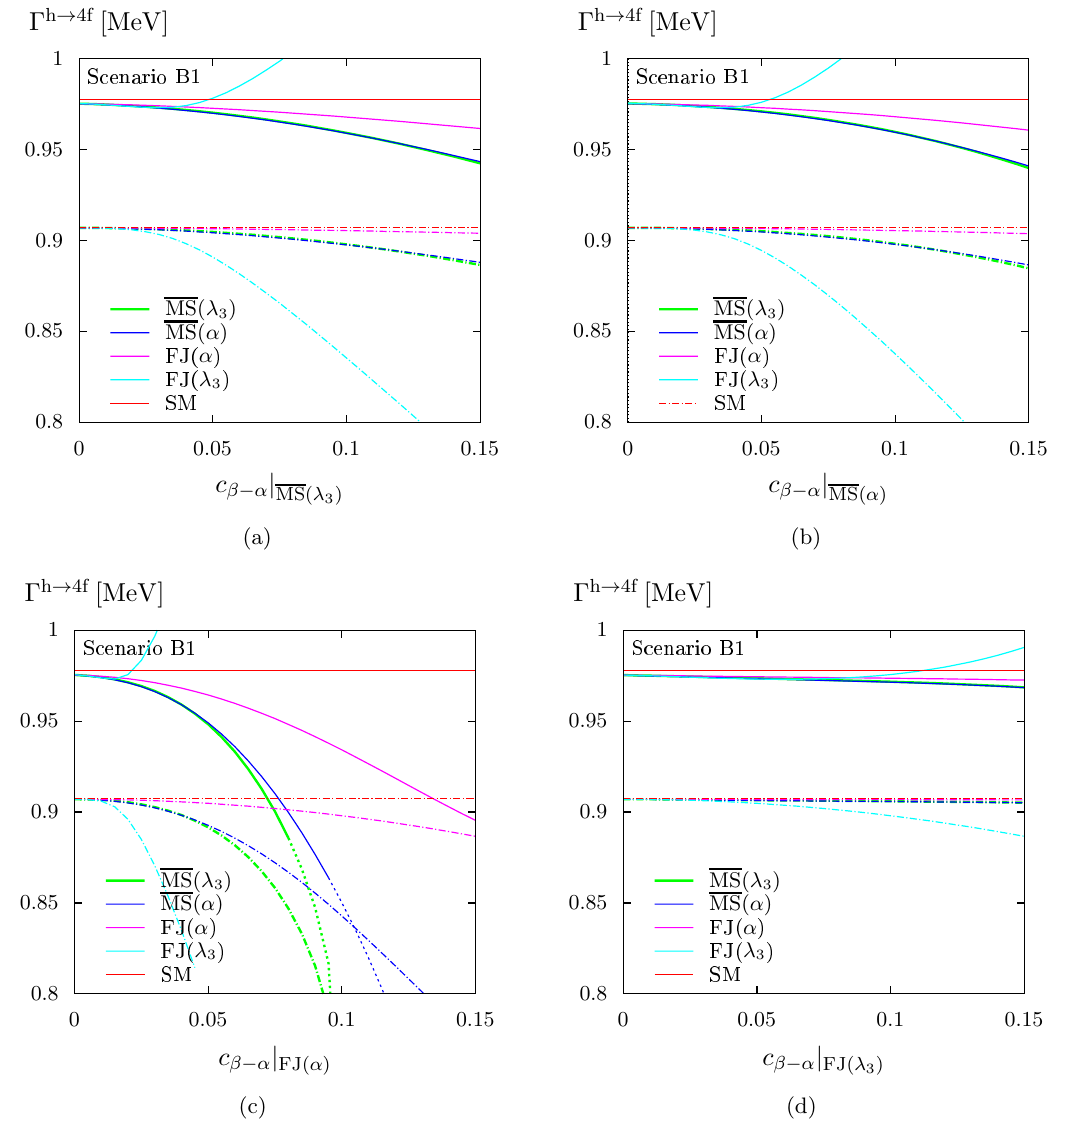
Figure 24 . The h 4 f width at LO (dashed) and NLO EW+QCD (solid) for scenario B1 in ! dependence of c (cid:12) (cid:0) (cid:11) . The panels (a), (b), (c), and (d) correspond to input values de(cid:12)ned in the MS( (cid:21) 3 ), MS( (cid:11) ), FJ( (cid:11) ), and FJ( (cid:21) 3 ) schemes, and they are converted to the other schemes at NLO (also for the LO curves). The result is displayed in all four schemes and for the SM using the colour code of (cid:12)gure 12. The breakdown of perturbativity ( (cid:21) max = (4 (cid:25) ) > 1) is visualized by using dotted k lines for the NLO